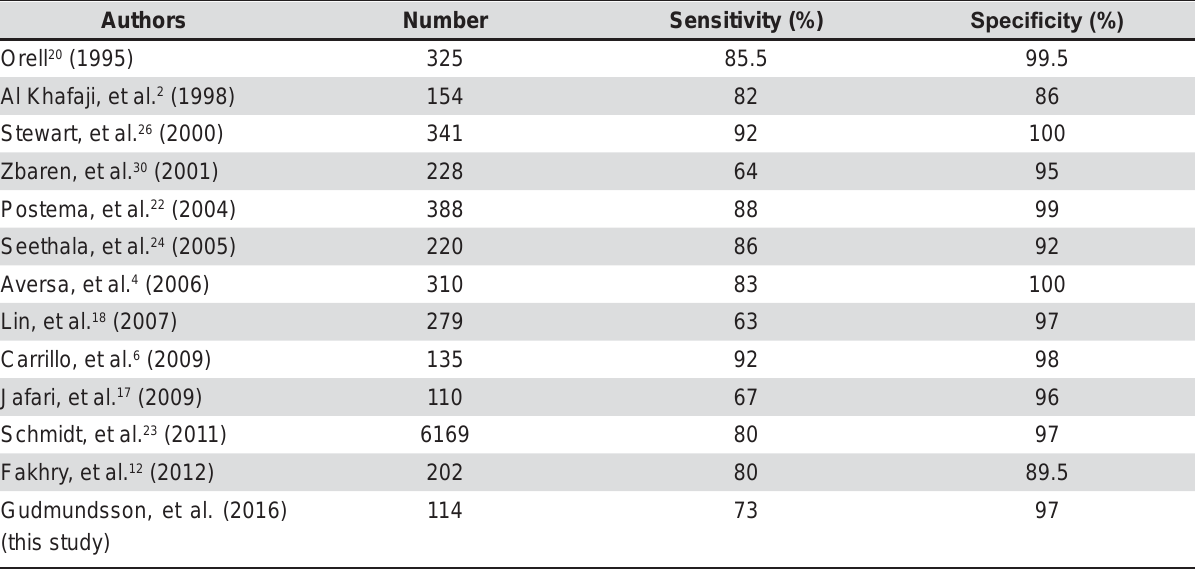
Table 3- (cid:3)(cid:54)(cid:72)(cid:81)(cid:86)(cid:76)(cid:87)(cid:76)(cid:89)(cid:76)(cid:87)(cid:92)(cid:3)(cid:68)(cid:81)(cid:71)(cid:3)(cid:86)(cid:83)(cid:72)(cid:70)(cid:76)(cid:191)(cid:70)(cid:76)(cid:87)(cid:92)(cid:3)(cid:82)(cid:73)(cid:3)(cid:191)(cid:81)(cid:72)(cid:16)(cid:81)(cid:72)(cid:72)(cid:71)(cid:79)(cid:72)(cid:3)(cid:68)(cid:86)(cid:83)(cid:76)(cid:85)(cid:68)(cid:87)(cid:76)(cid:82)(cid:81)(cid:3)(cid:70)(cid:92)(cid:87)(cid:82)(cid:79)(cid:82)(cid:74)(cid:92)(cid:3)(cid:11)(cid:41)(cid:49)(cid:36)(cid:38)(cid:12)(cid:3)(cid:73)(cid:82)(cid:85)(cid:3)(cid:83)(cid:68)(cid:85)(cid:82)(cid:87)(cid:76)(cid:71)(cid:3)(cid:74)(cid:79)(cid:68)(cid:81)(cid:71)(cid:3)(cid:87)(cid:88)(cid:80)(cid:82)(cid:85)(cid:86)(cid:17)(cid:3)(cid:38)(cid:82)(cid:80)(cid:83)(cid:68)(cid:85)(cid:76)(cid:86)(cid:82)(cid:81)(cid:3)(cid:90)(cid:76)(cid:87)(cid:75)(cid:3) previous